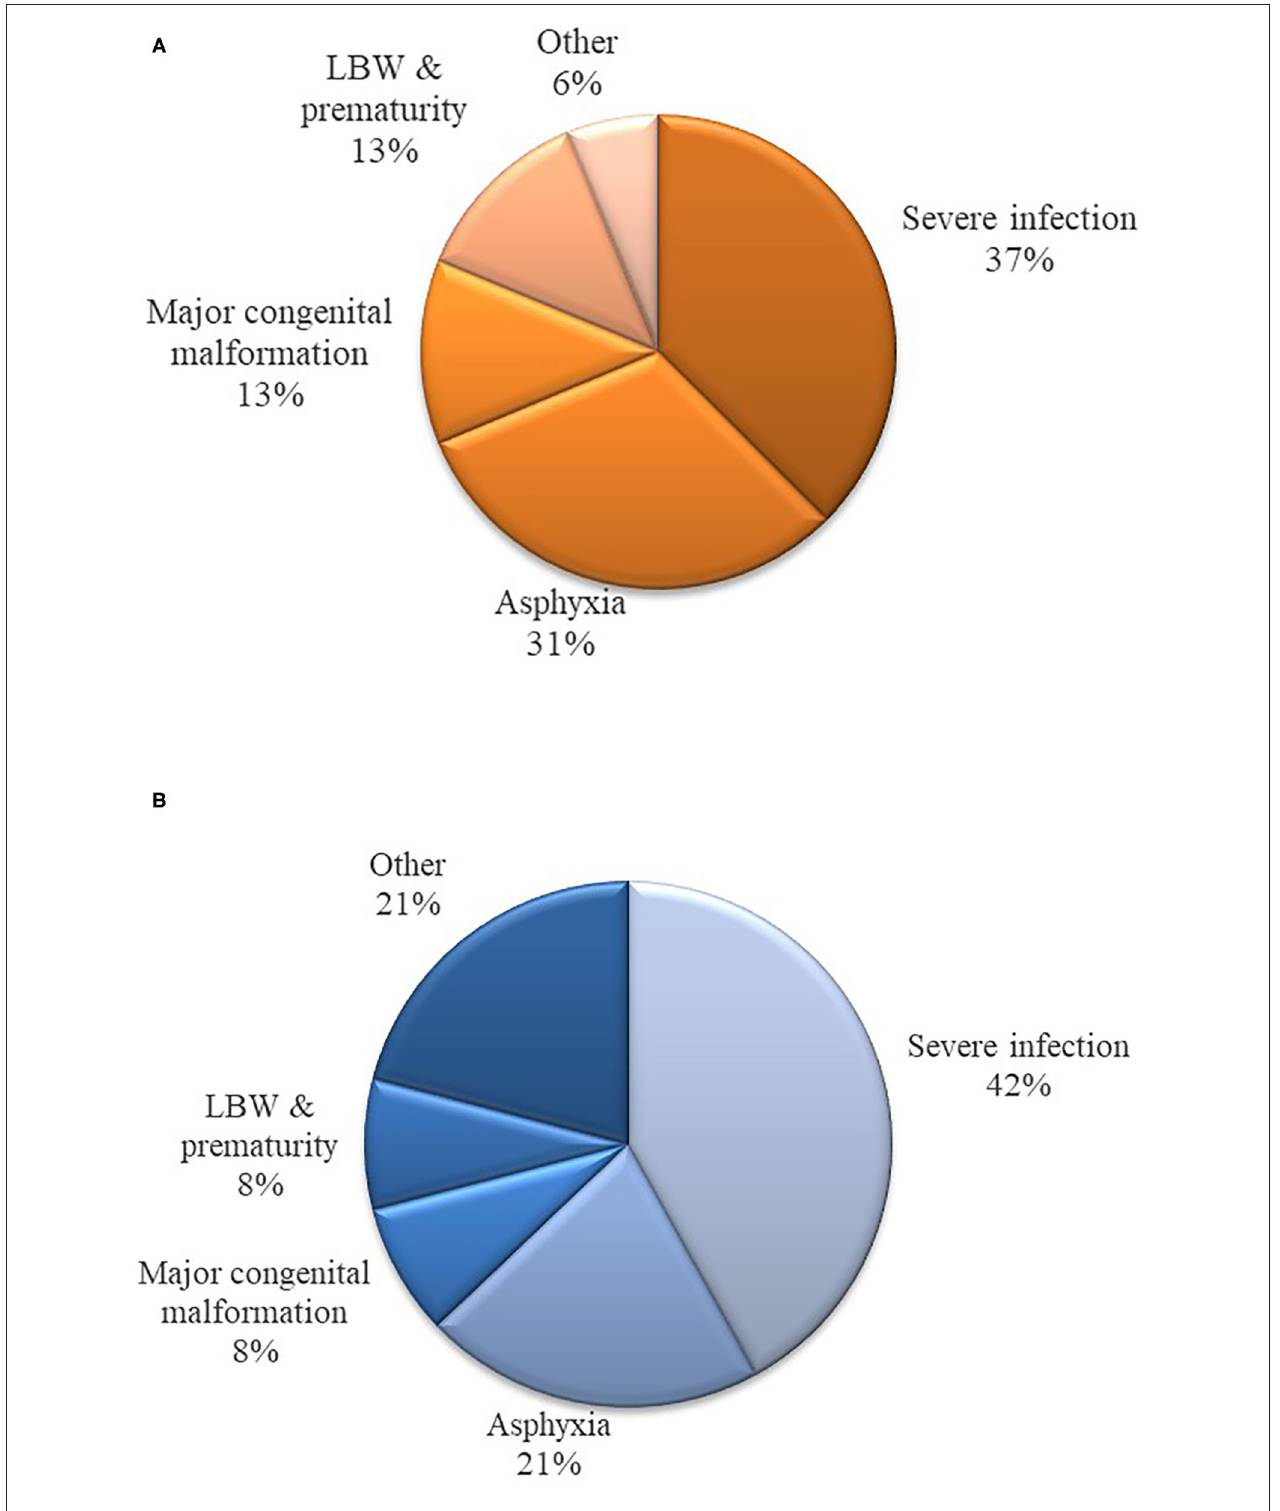
FIGURE 2 | (A) Main diagnoses at hospitalization during the study period (0–56) days. (B) Main diagnoses of death during the study period (0–56) days.